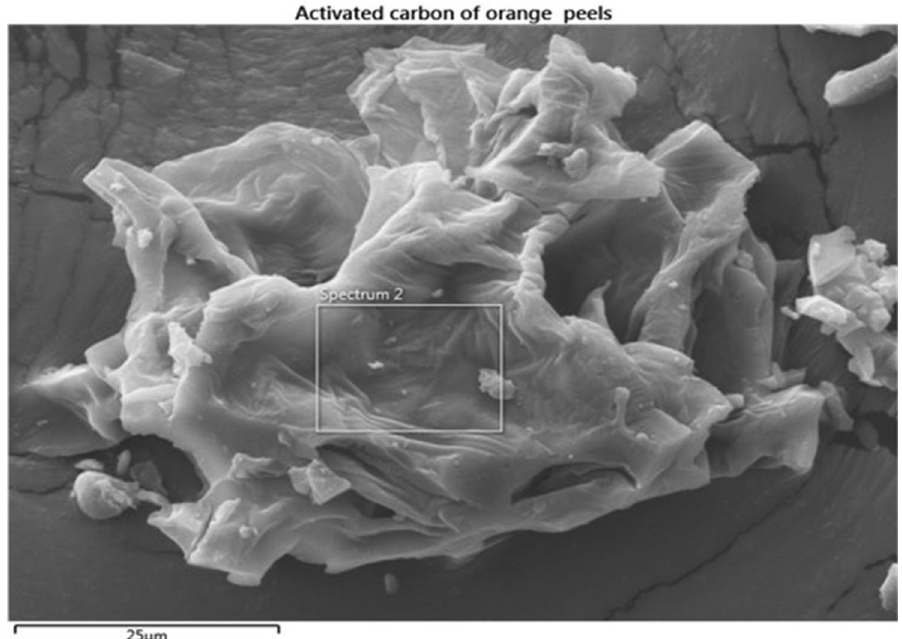
Fig. 5 Scanning electron micro- scopic analysis of activated carbon made from orange